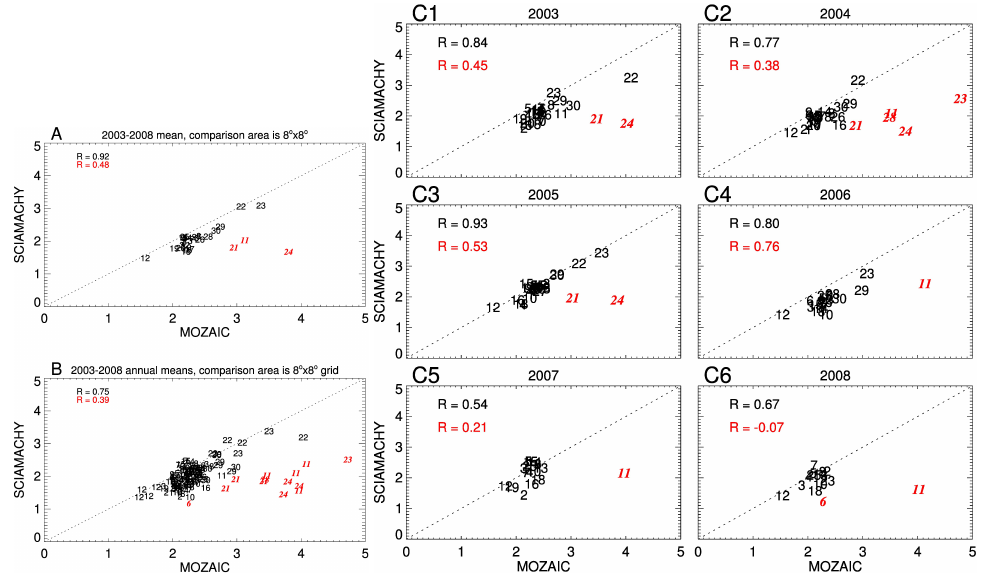
Fig. 4. blackboxplease give a section for figure 4. thank